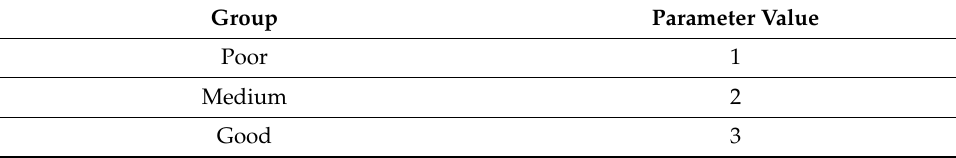
Table 8. Criteria values.